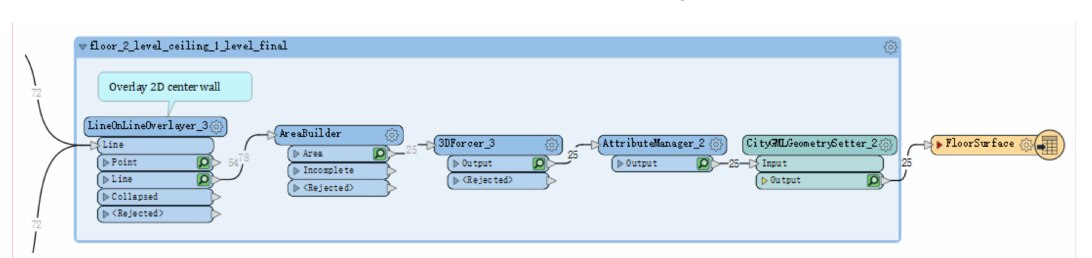
Figure 20. Extraction of ceilings.